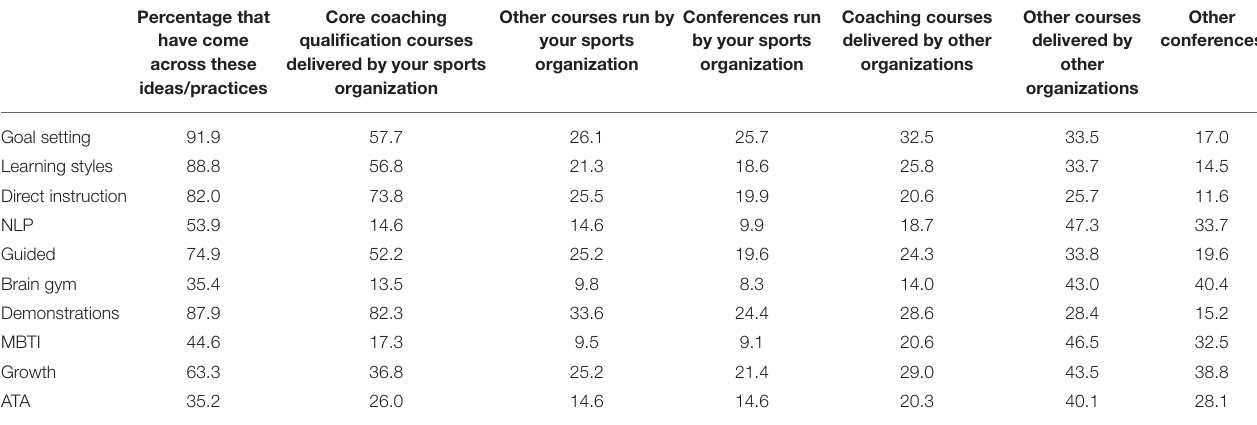
TABLE 3 | Coaches exposure to different learning-based and brain-based ideas. Percentage that have